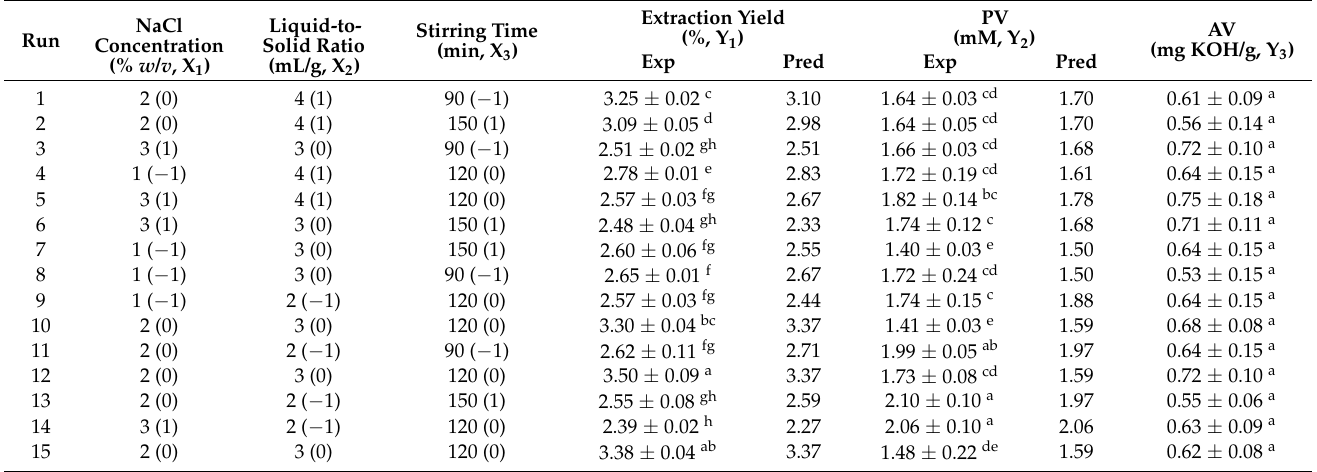
Table 2. The experimental run and extraction conditions for the Box–Behnken design (BBD) with coded levels of each variable (blanket), including the response values for the extraction yield, PV, and AV of silkworm pupae oil.